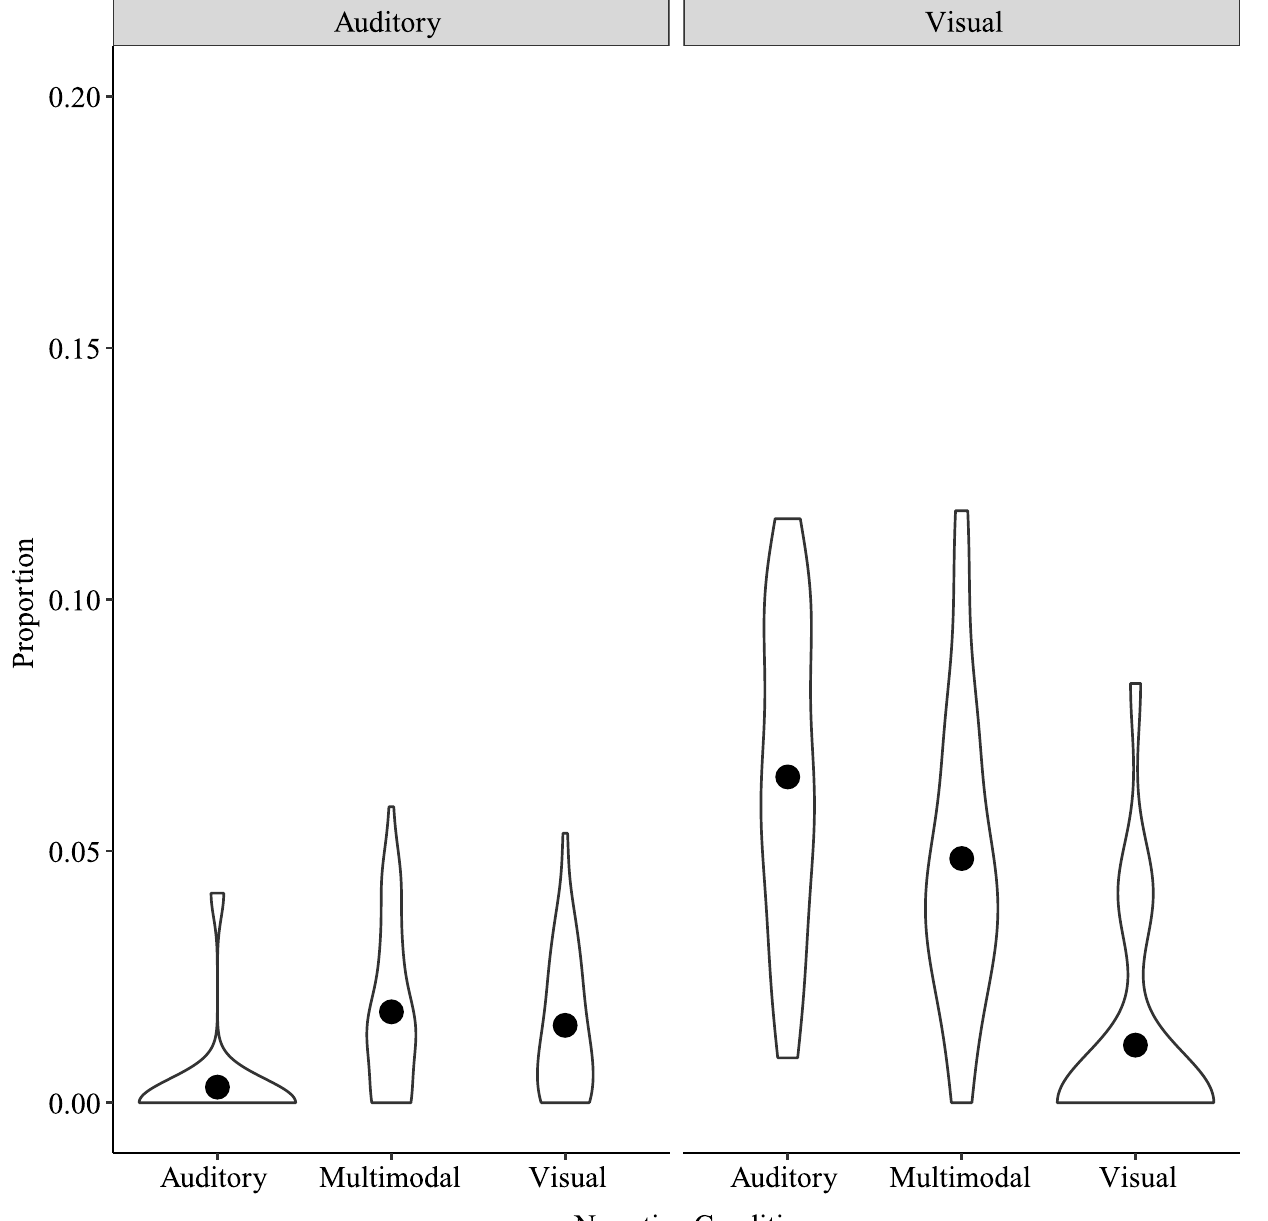
PLOS ONE | https://doi.org/10.1371/journal.pone.0249950 April 14,